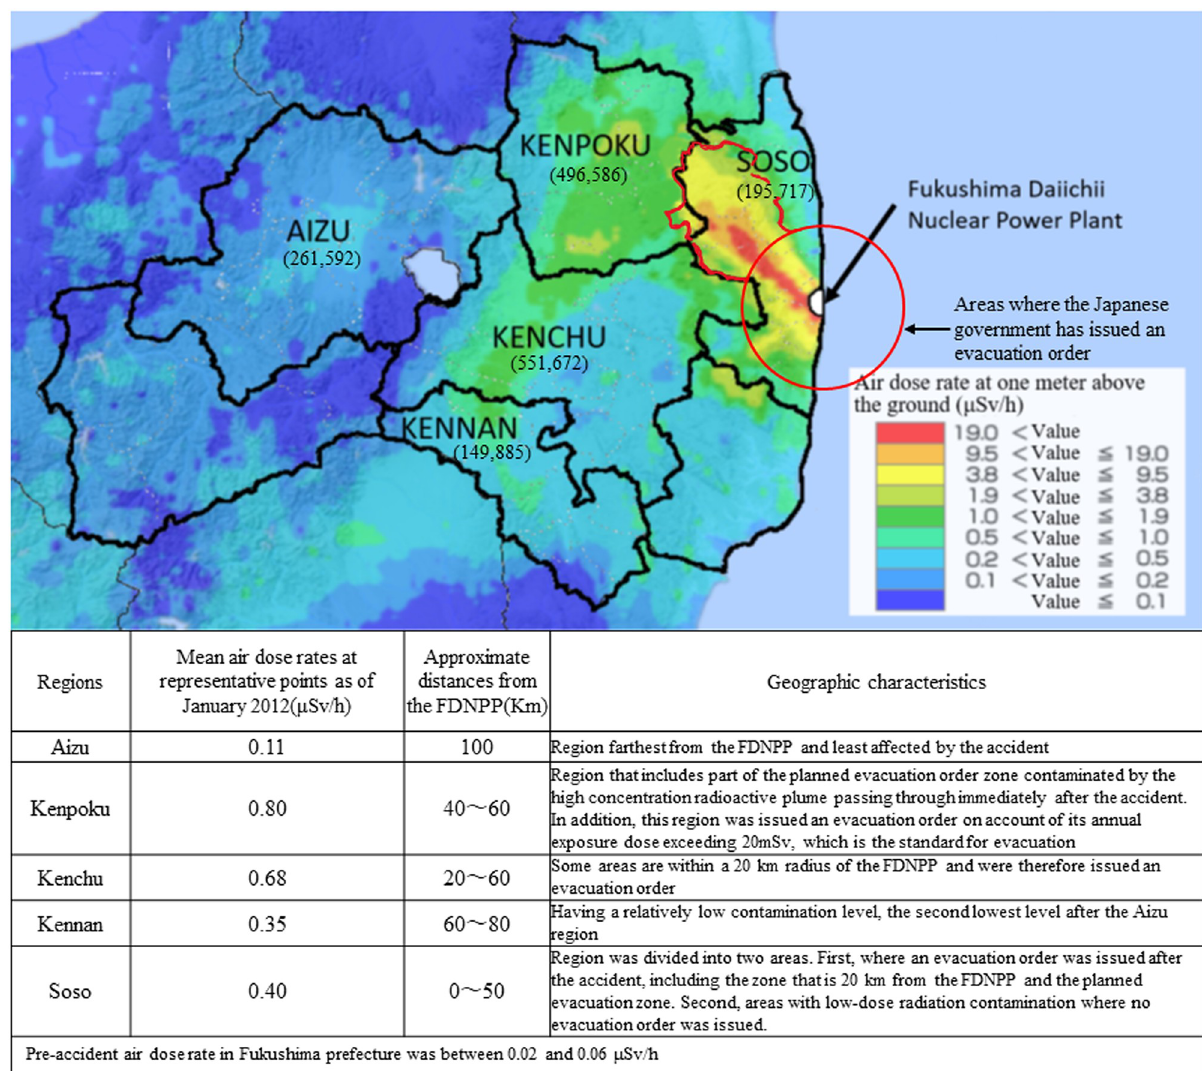
Fig 1. Five administrative districts of Fukushima prefecture and aircraft monitoring to measure